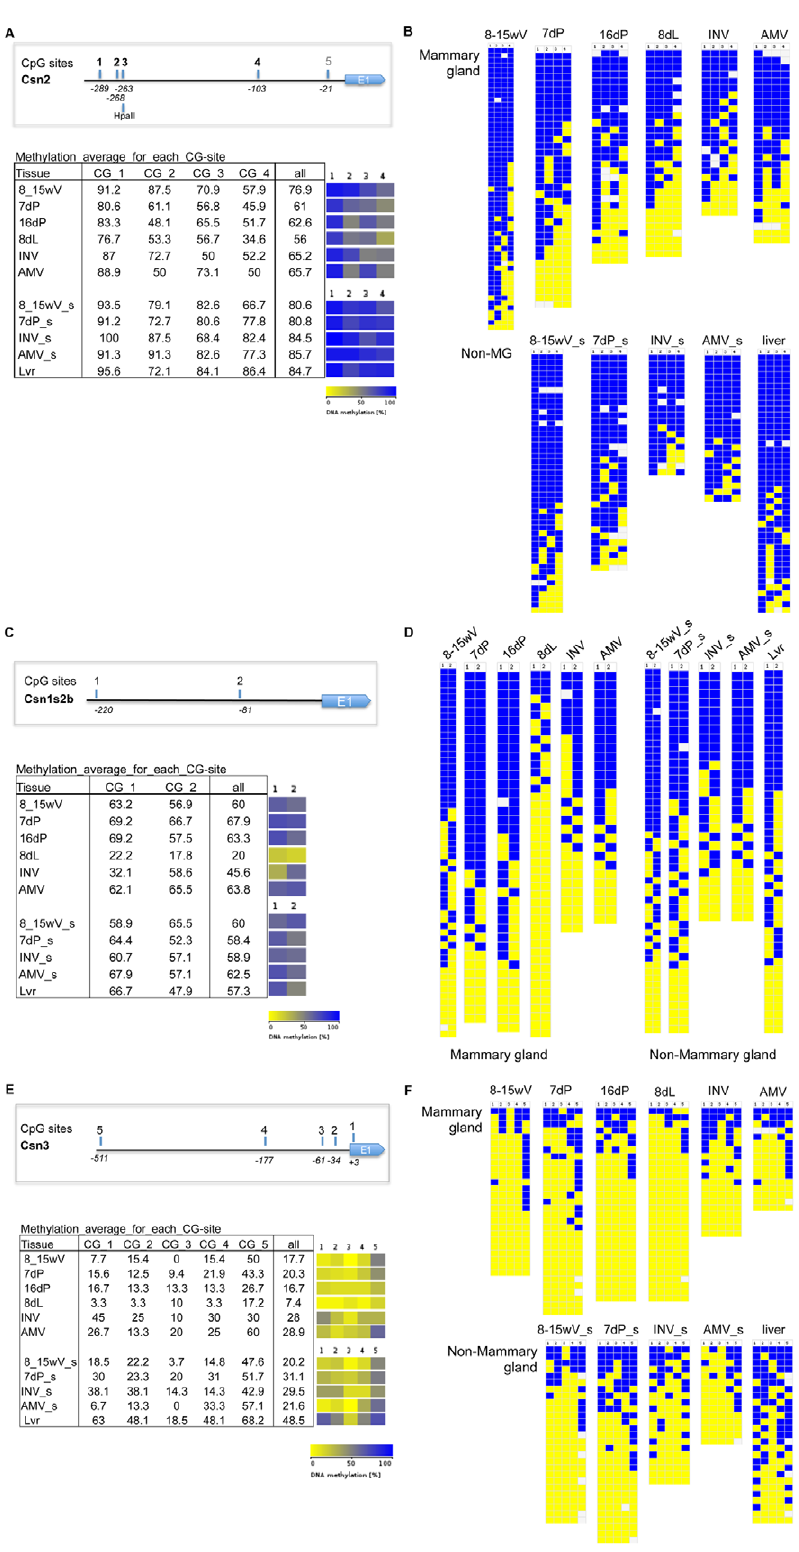
Figure 6. DNA methylation levels during mammary gland development and differentiation at casein gene promoters. ( A, B ) DNA methylation levels (%) for Beta-casein promoter (Csn2) (average of 4 CpG sites in 326 bp), ( C,D ) Alpha s2b casein promoter (Csn1s2b) (average of 2CpG sites in 300 bp) and ( E,F ) Kappa casein promoter (Csn3) (average of 5 CpG sites in 588 bp) were determined by bisulfite cloning and sequencing. Mammary epithelial Cell enriched fractions (MEC) : Virgin (8_15V; 8–15 week old virgins,); Pregnancy (7P: 7day pregnant females); Inv ( . 28 day after lactation); AMV: Age Matched Virgin (Virgin animals same age as . 28 day involuted animals). Whole tissue: pregnancy (16P: 16 days